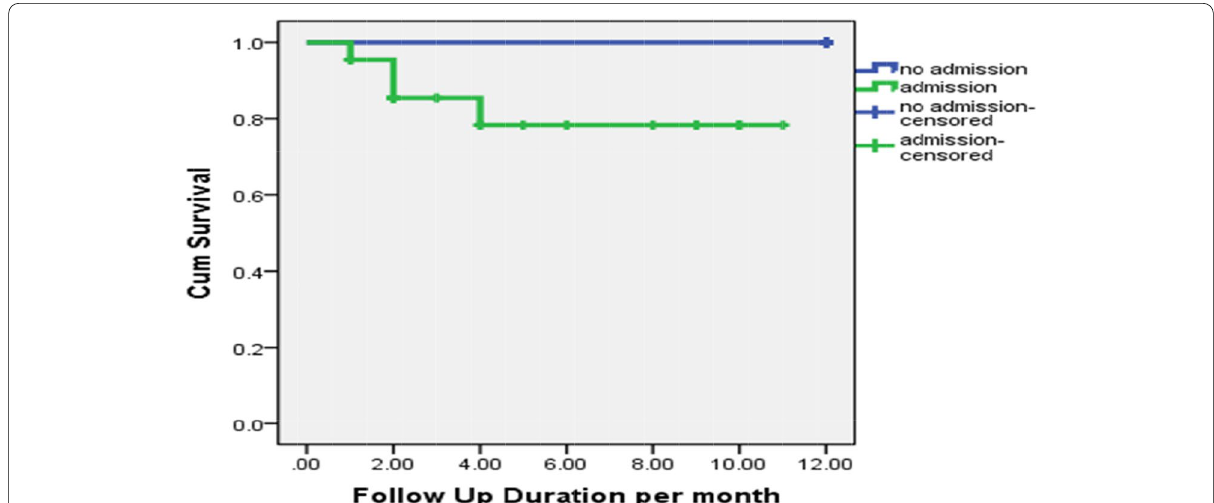
Fig. 2 Kaplan‑Meier survival analysis at 12 months of follow‑up for survival of 103 SLE patients stratified according to admission to ICU. Non‑admitted patients have 100% of survival and admitted patients have 78.9% of survival which is statistically significant by Log‑rank test